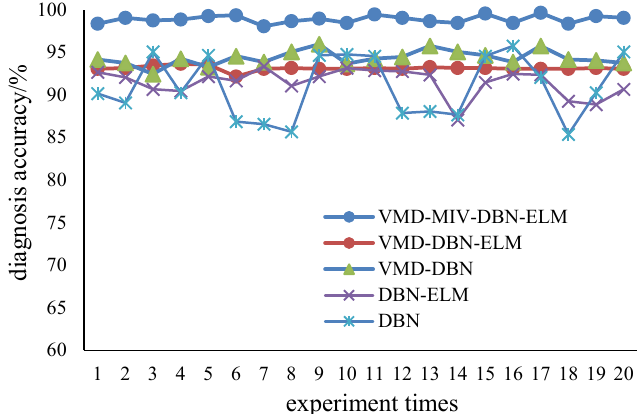
Figure 8. Online fault diagnosis.